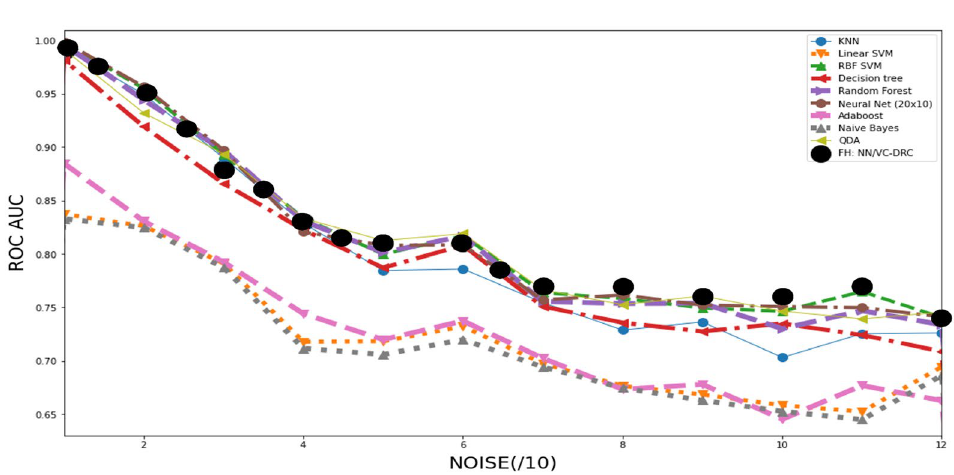
Figure 11. VC–DRC example for two Blocks and one entangling layer per block (B = 2 , L =